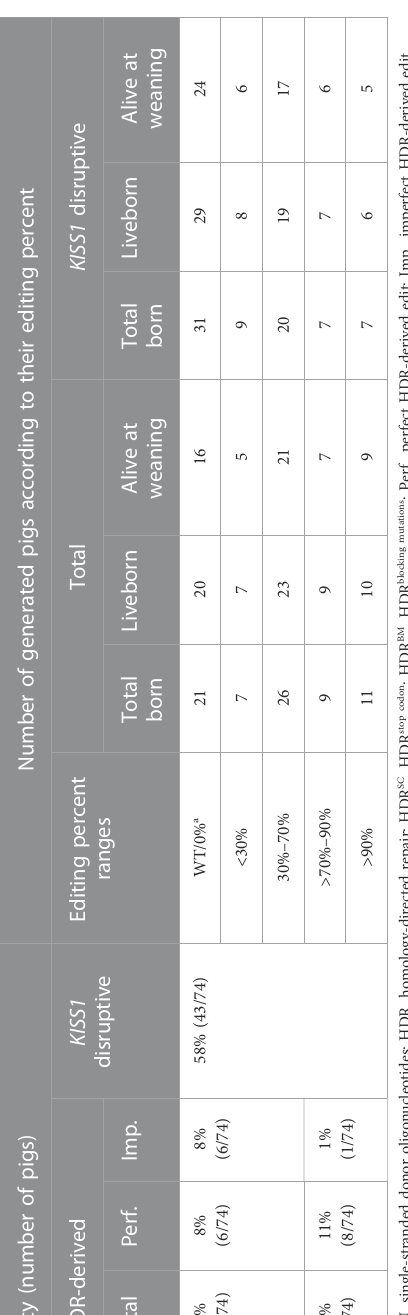
observations and hormonal data (Supplementary Figure